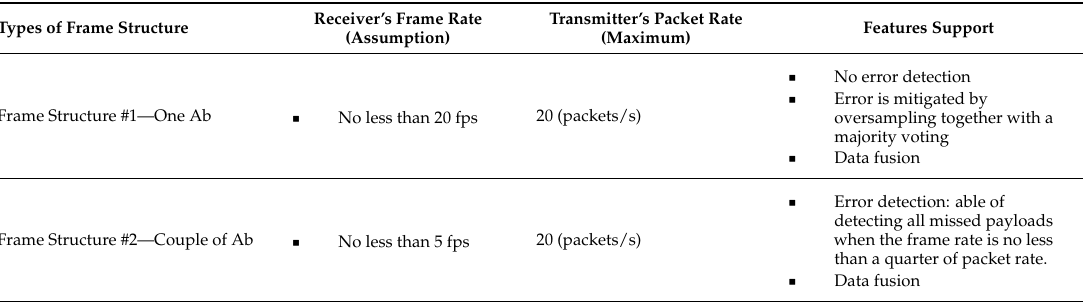
Table 5. Experimental Parameters for the Proposed Frame